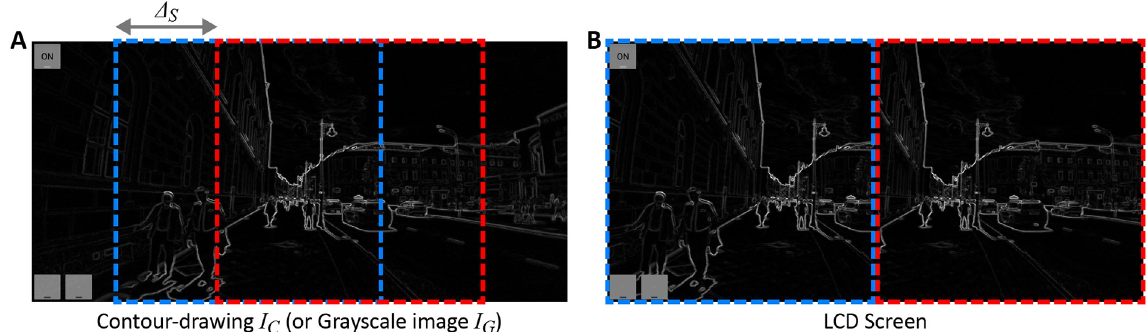
Fig 2. (A) Regions of two image segments (blue and red) taken from the contour-drawing I image composed of these segments on the LCD screen. These regions are horizontal translations of one another for Δ S in I G and I C